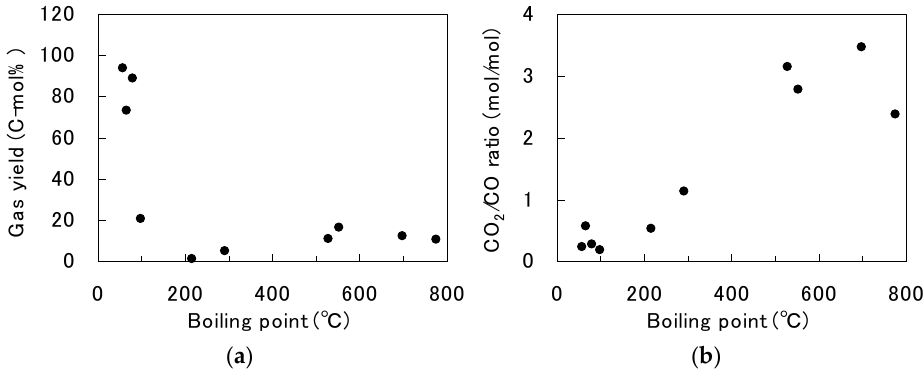
Figure 8. Dependence of the ( a ) total gas yield (excluding H 2 ) and ( b ) CO 2 /CO ratio on the boiling point of the sample (constructed from the data in Figure 7).